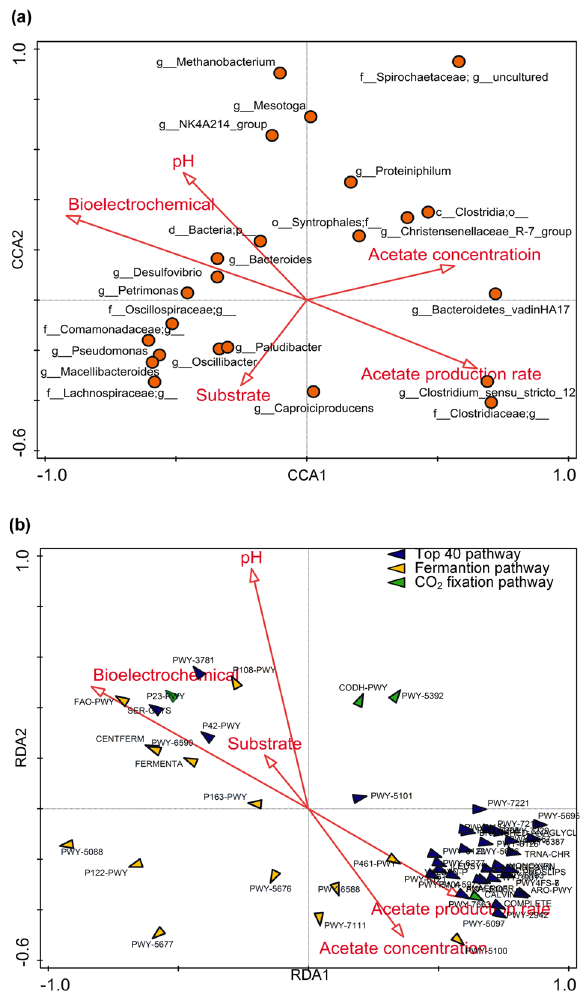
Fig. 8 Effects of environmental variables on core features and predicted pathways. a Canonical correlation analysis (CCA) of core features, environmental variables, and acetogenic performance as well as b redundancy analysis (RDA) of predicted pathways, environmental variables, and acetogenic performance. The full name of each pathway can be found on MetaCyc database (https://